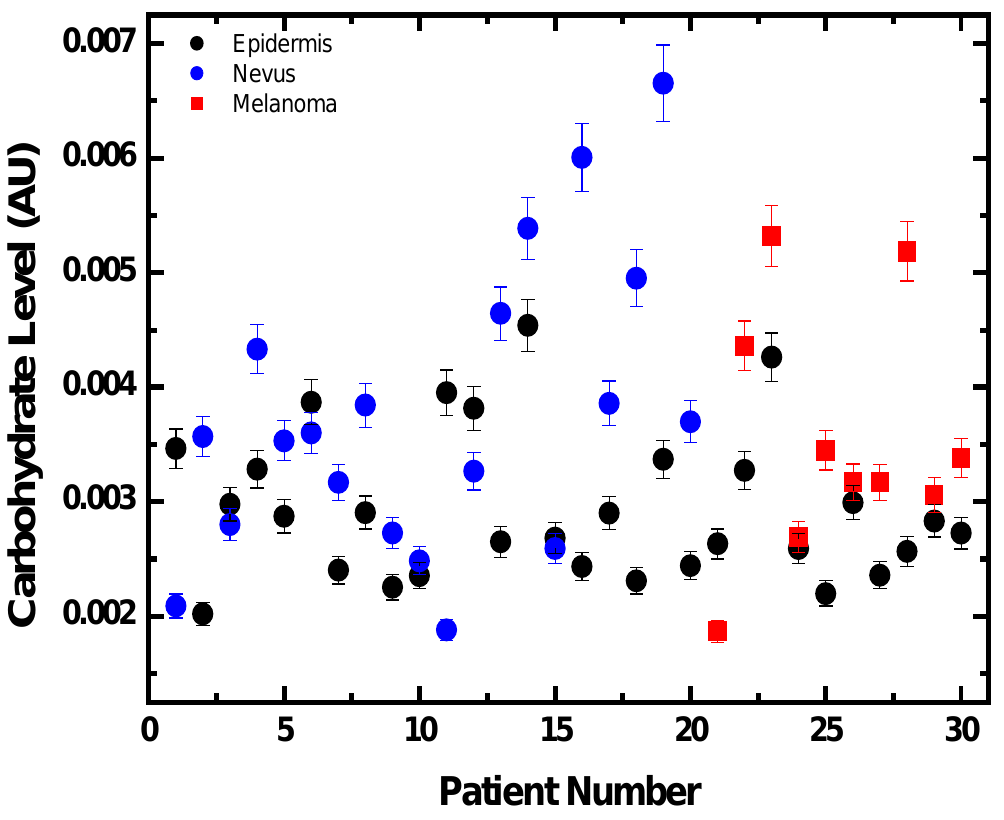
FIGURE 2. Variations in the glucose levels between epidermis, compound nevus, and melanoma as quantified from